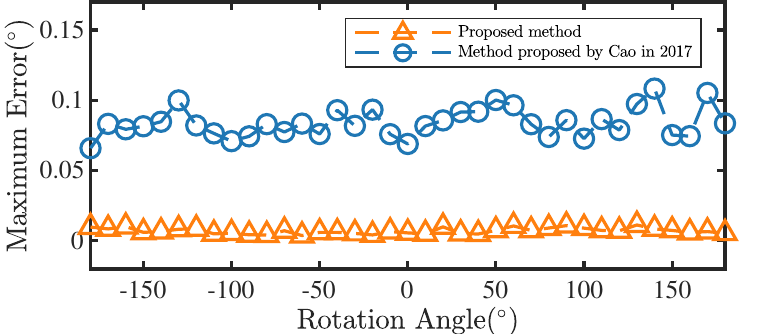
Figure 11. Maximum measurement errors of the two methods for different rotation angles [16].